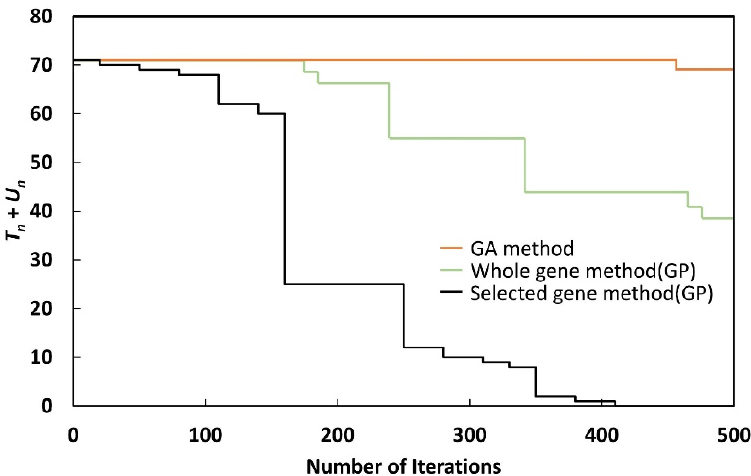
Figure 16. GP results for the minimized fitness function (2025).